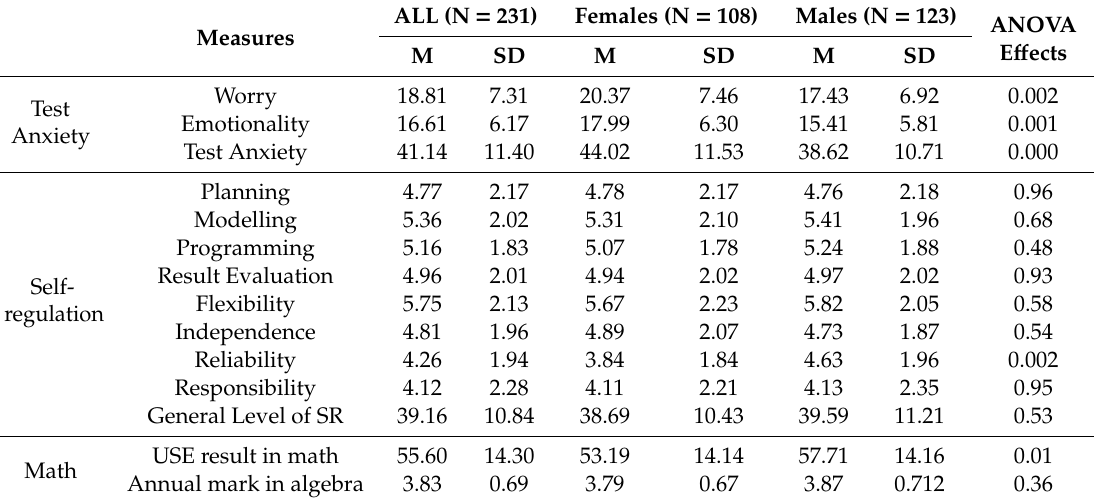
Table 1. Means, standard deviations and ANOVA results by